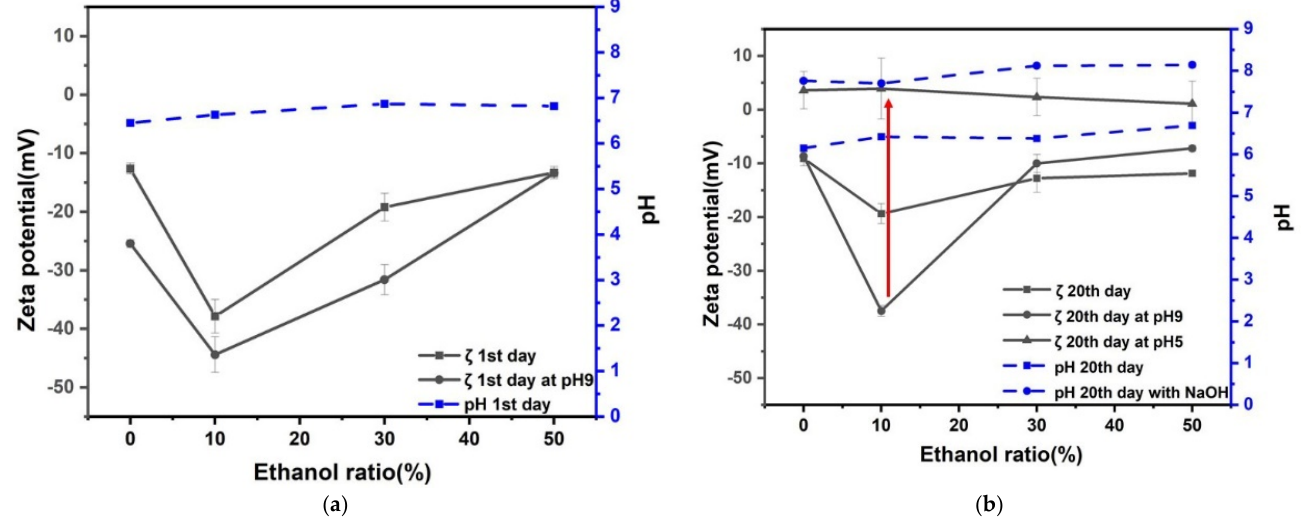
Figure 4. Zeta potential and pH for 8% H 2 in Ar nanobubbles as a function of ethanol percentage of ethanol aqueous solution mixtures after: ( a ) 1 day and ( b ) 20 days.